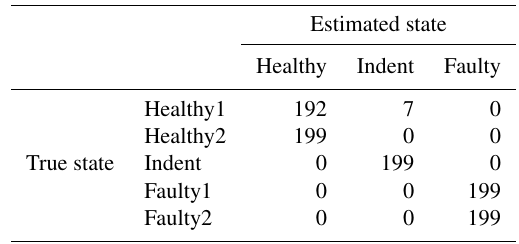
Figure 11. Scatterplot of top two features for the 1500rpm PCB dataset. Table 1. Confusion matrix for 3000rpm PCB data and the top three